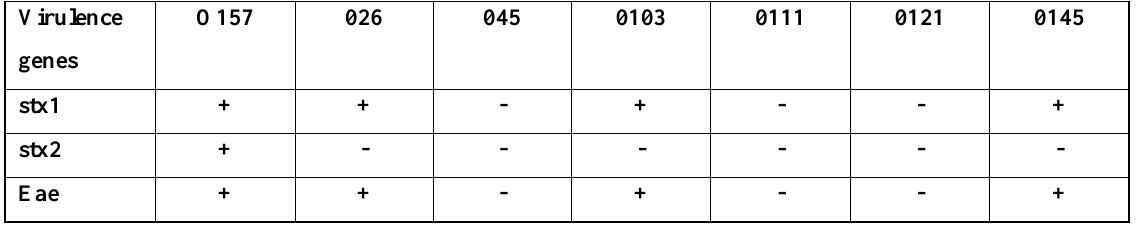
Plate 1. Six (6) bacterial isolates amplified by 16s